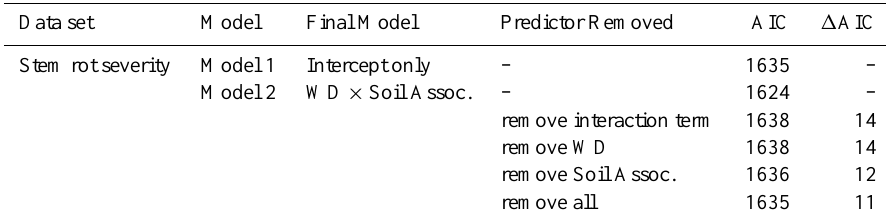
Table 3. Changes in model fit based on Akaike’s Information Criterion (AIC) with removal of single factors from the most-supported linear mixed-model testing associations of the stem rot severity (percent stem volume lost to rot) in trees of mixed dipterocarp rain forest, Central Sarawak, Borneo, in the felling data set. The (cid:49) AIC shows the increase in AIC when each predictor is removed from the final model. Species identity was specified as a random effect. The fixed effects shown are those retained in the best-supported model after model selection based on AIC; see Sect. 2 for details. The following predictor variables were not retained in the final models either as main effects or interactions and so had little effect on variation in stem rot severity: Model 1, DBH, species wood density and soil PC1, PC2, PC3, and PC4; Model 2, DBH. Abbreviations are as follows: WD, wood density and Soil Assoc., species soil association. When all predictors are removed, the model is an intercept-only